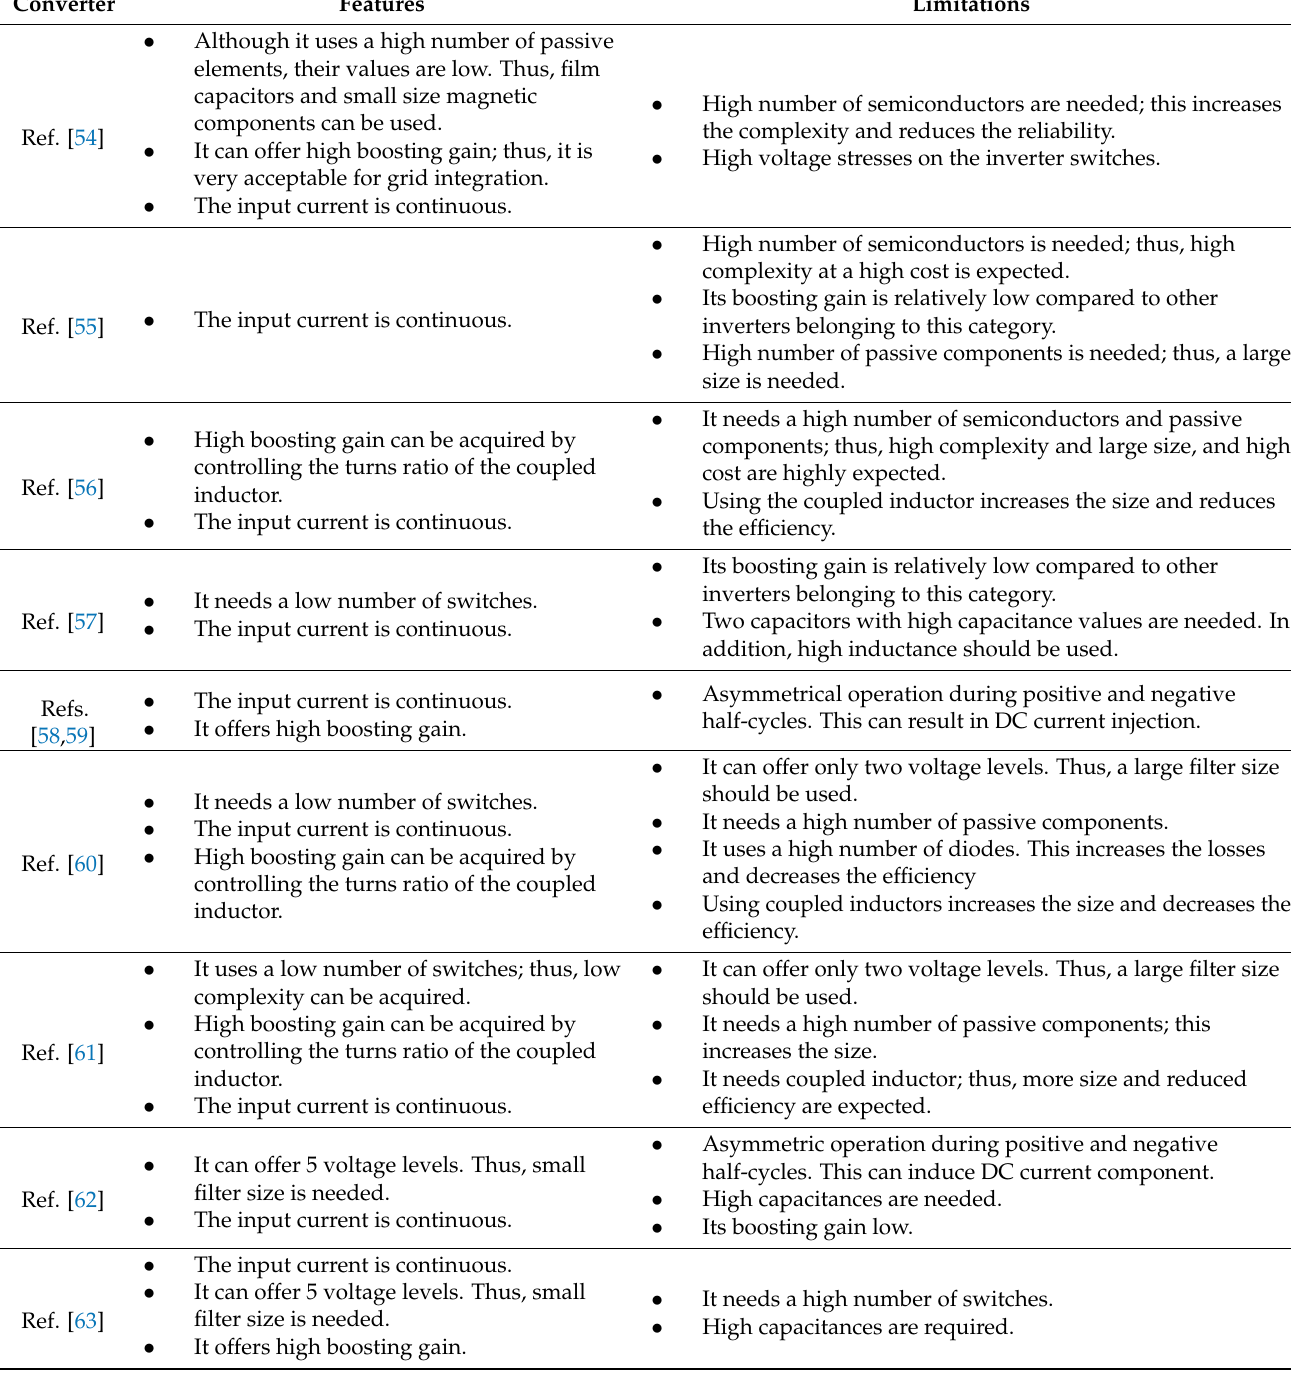
Table 6. Features and limitations of voltage-source CG converters (boosting